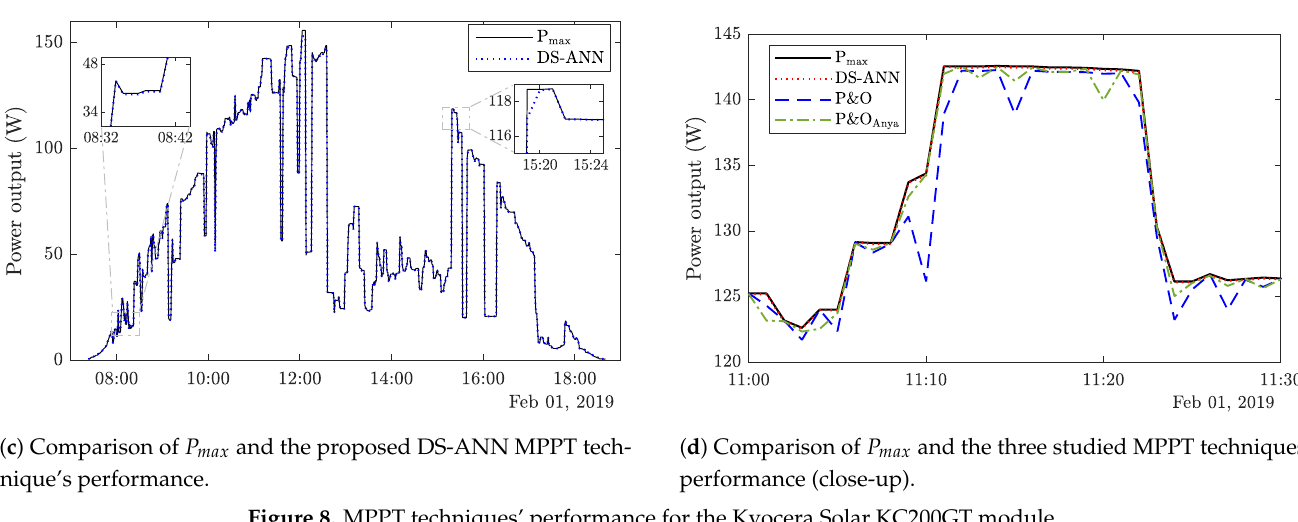
Figure 8. MPPT techniques’ performance for the Kyocera Solar KC200GT